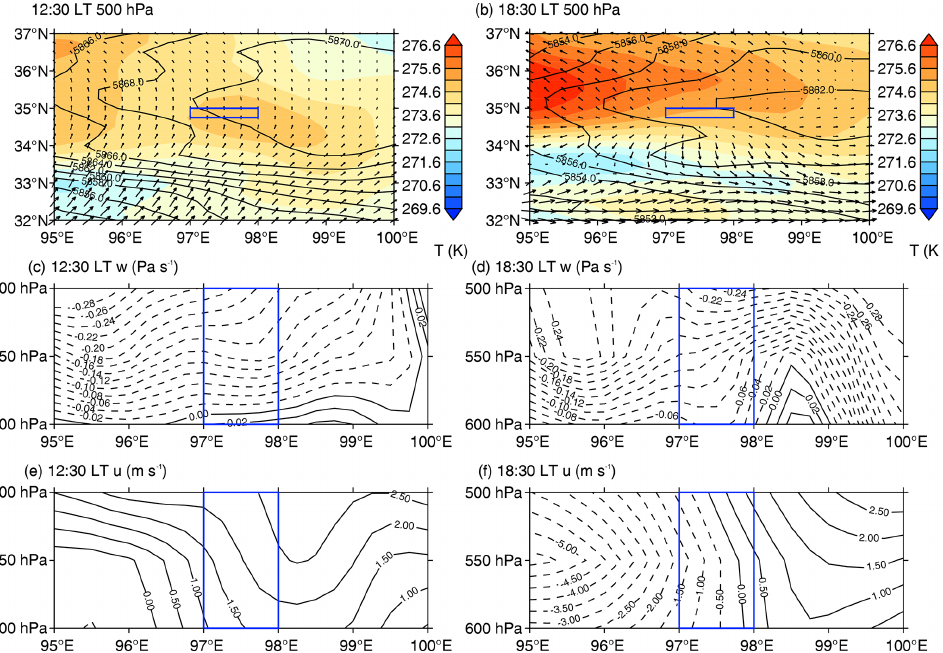
Figure 3. Synoptic background on 29 July 2012. Blue boxes represent the two lakes area. Panels (a) and (b) show the wind field, temperature field, and geopotential height field at 500hPa ( ∼ 5500m) at 12:30LT (a) and at 18:30LT (b) . The vertical wind ( w , c , d ) and the zonal wind ( u , e , f ) below 500hPa are also